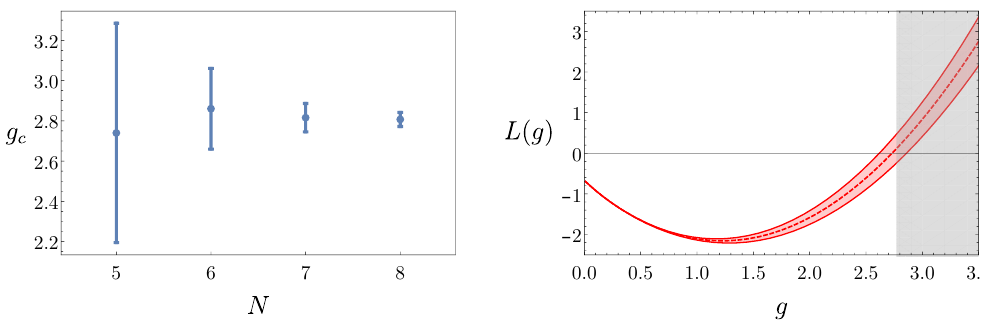
Figure 8 . (Left panel) Central value and error of g c as a function of the number of loops N kept in the conformal mapping resummation technique. (Right panel) The inverse of the logarithmic derivative of the physical mass M as a function of the coupling constant g using a [4 = 2] Pad(cid:19)e-Borel approximant. This expression allows us to determine the critical exponent (cid:23) , as explained in the main